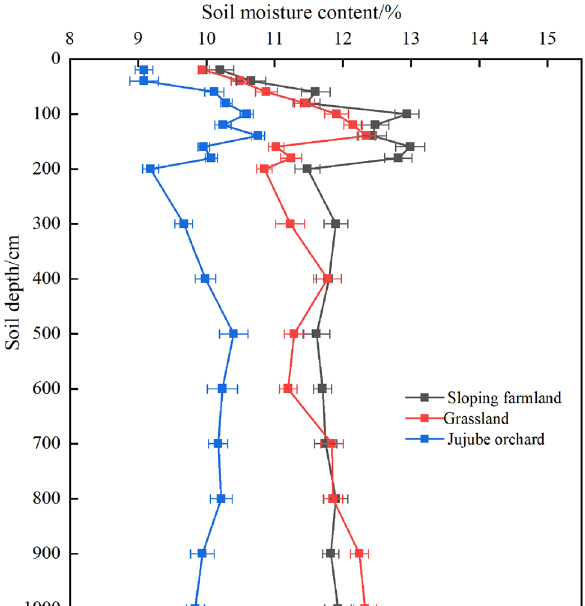
Figure 2. Soil depth distribution of soil